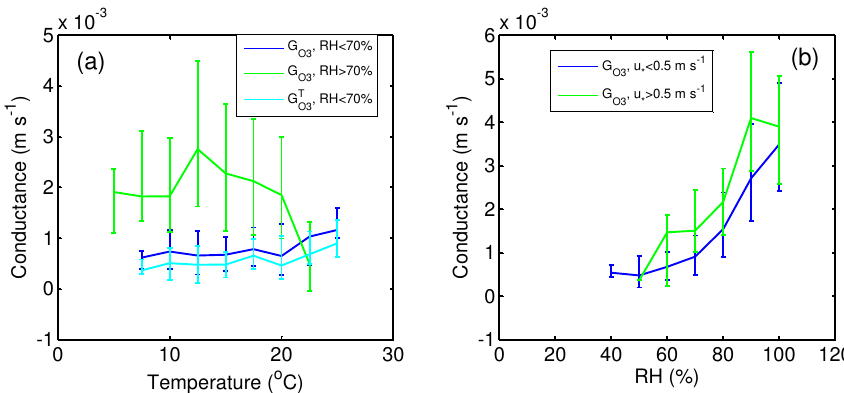
Fig. 7. Dependence of conductance on temperature (a) and RH (b) at night (elevation angle of Sun<0 ◦ ) during the peak of the growing season weeks 25–34. Medians of 30min average observations together with quartiles are presented.